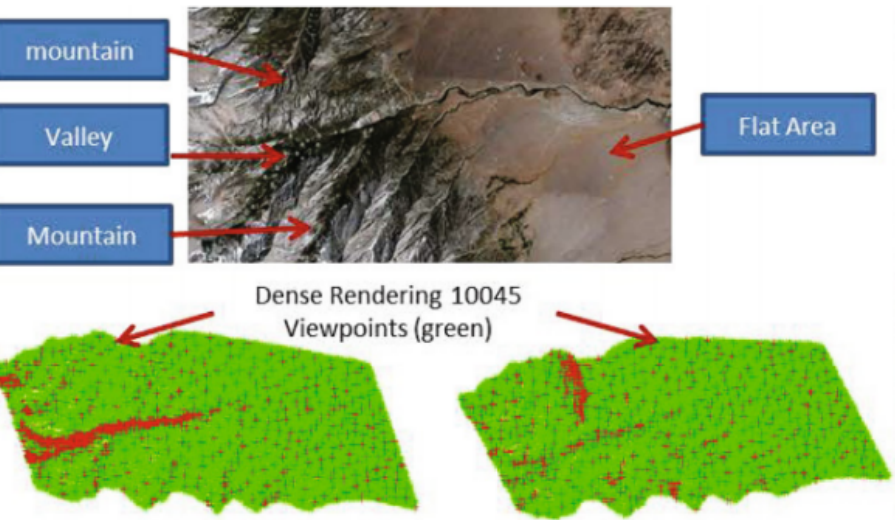
Figure 7. The effect of clustering DEM skyline dataset. (Top): The terrain of the localization area; and (Bottom) results of clustering DEM skylines in 0 ◦ and 90 ◦ directions, respectively. The green points are the sampling points of the DEM skyline, and the red points are the tolerance regions. The sampling points of a skyline in two directions are different due to the influence of